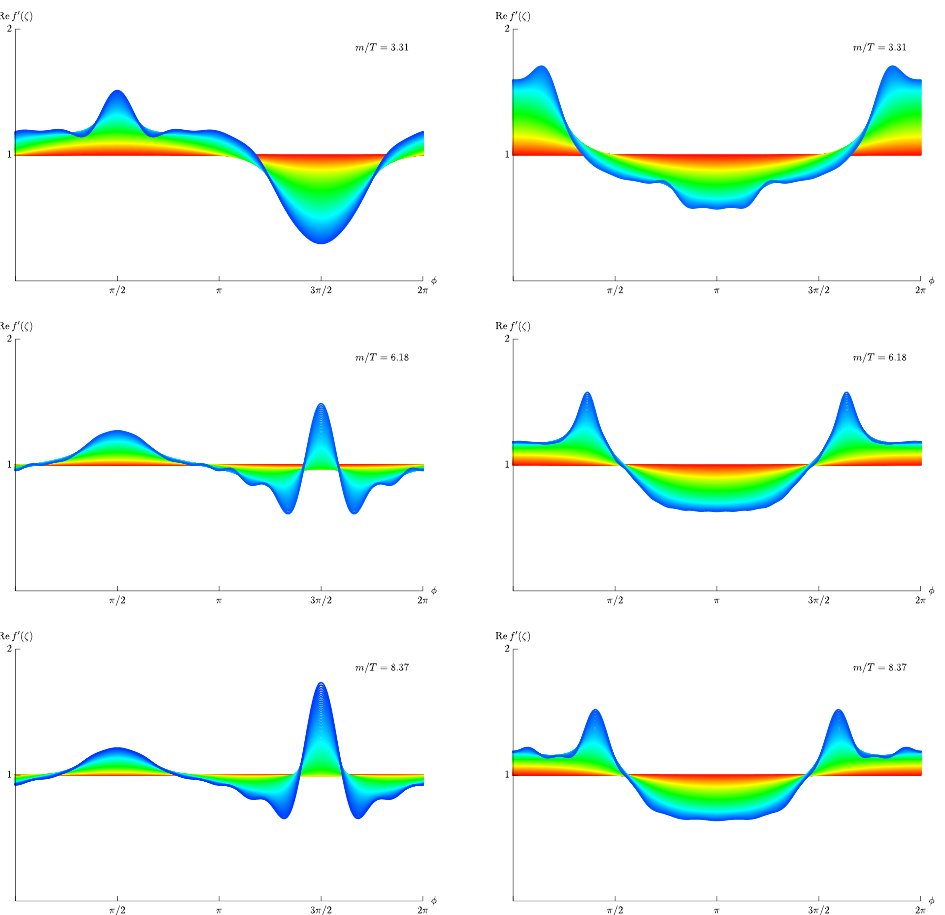
Figure 7 . We show that in all three cases considered in the longitudinal channel, sound modes (shown in the left panels ) and diffusive modes (shown in the right panels ) are univalent on the entire disks of convergence U = D R . All plots are made for ζ = | ζ | e iφ and φ ∈ [0 , 2 π ] , with | ζ | ranging from 0 (in red) to 0 . 85 (in blue). The oscillations that are visible in the plots are a numerical artefact of the interpolations (fits) of the dispersion relations and are not physical. While the numerical uncertainties grow for larger | ζ | than those plotted here, we are confident that the dispersion relations remain univalent all the way to | ζ | → 1